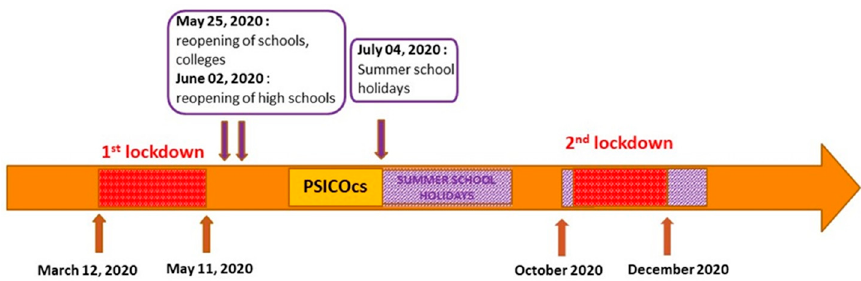
Figure 1. Timeline of the PSICOcs